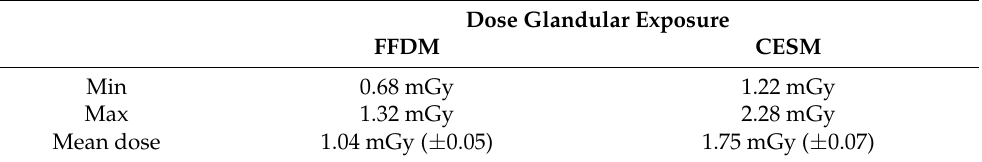
Table 1. Minimum (min), maximum (max) and mean dose exposure for FFDM and